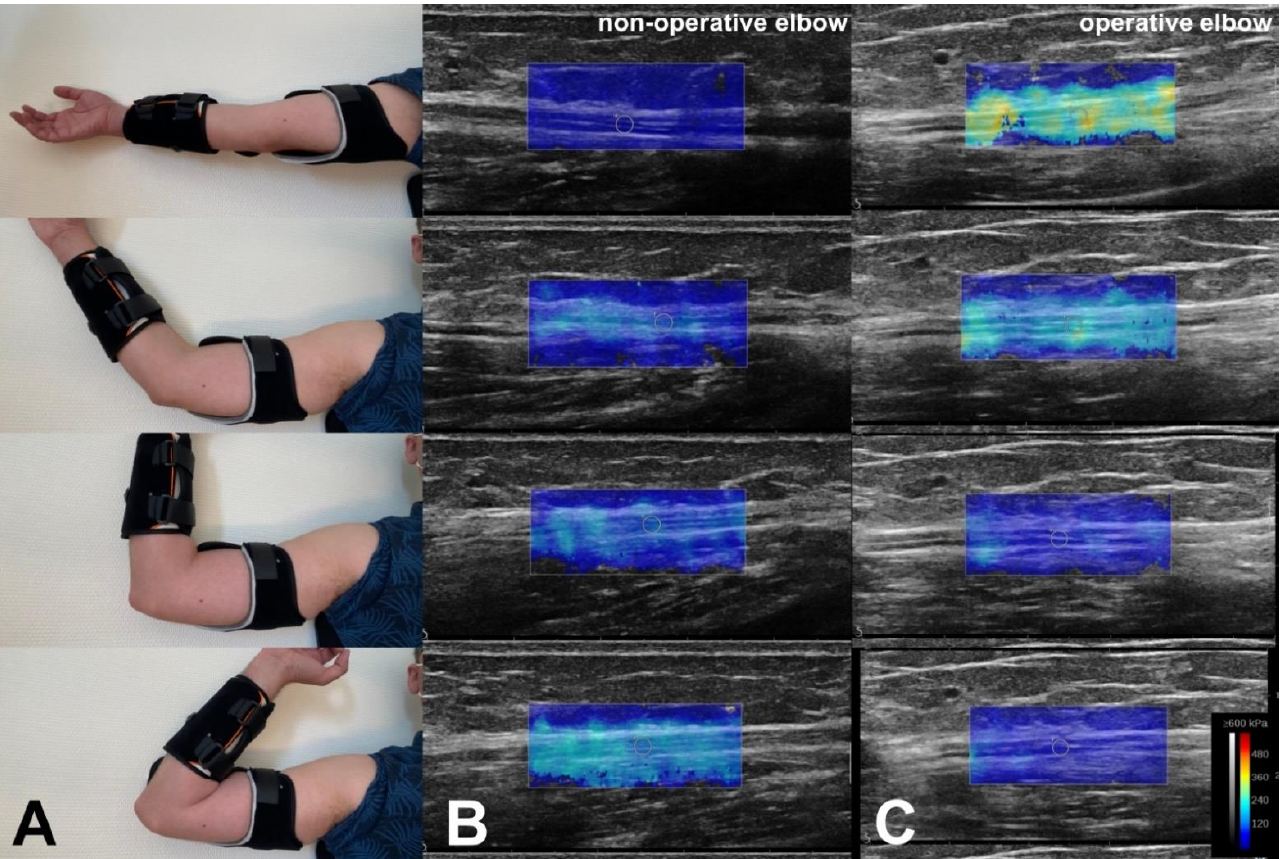
Figure 2. Examples of shear elastic modulus measurement of the ulnar nerve at 0- (image at top), 45-, 90- and 120-degree flexion of the elbow in an Elbo ™ brace ( A ). The colored region represents the shear elasticity map in a healthy ulnar nerve ( B ) and an ulnar nerve after anterior transposition ( C ) with a color scale (see bottom right), with blue representing lesser stiffness and red greater stiffness. The software allowed us to measure the mean shear elasticity value over a 2 mm 2 Q-Box focus area.